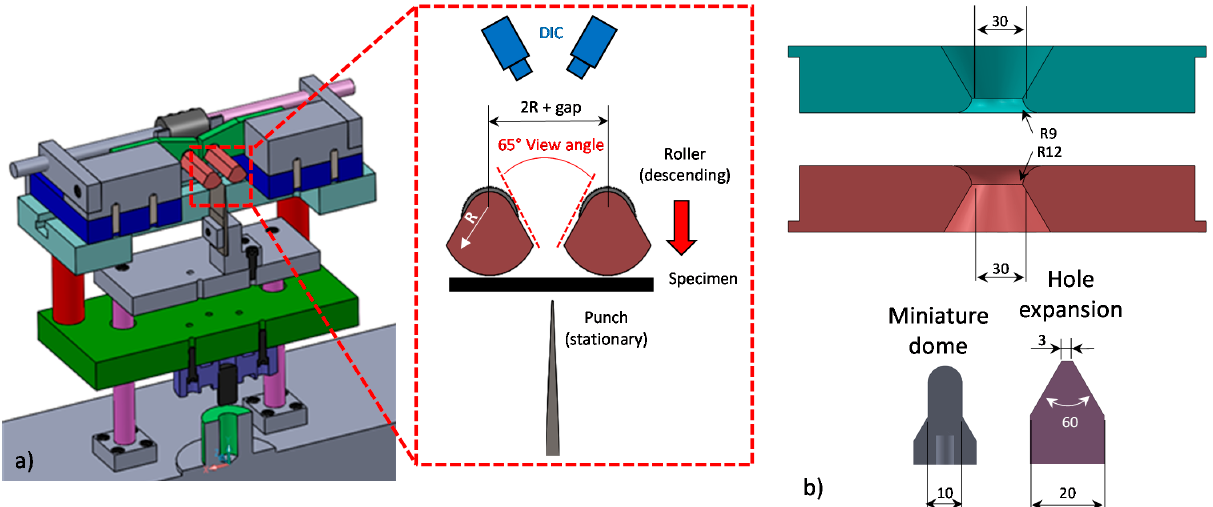
Figure 25. Schematic of the V-Bend frame utilized for characterizing the fracture strain under plane strain tension ( a ) and die set utilized to perform miniature dome tests and hole expansion tests to characterize the fracture limit under equi-biaxial tension and uniaxial tension. Units are in mm ( b ).